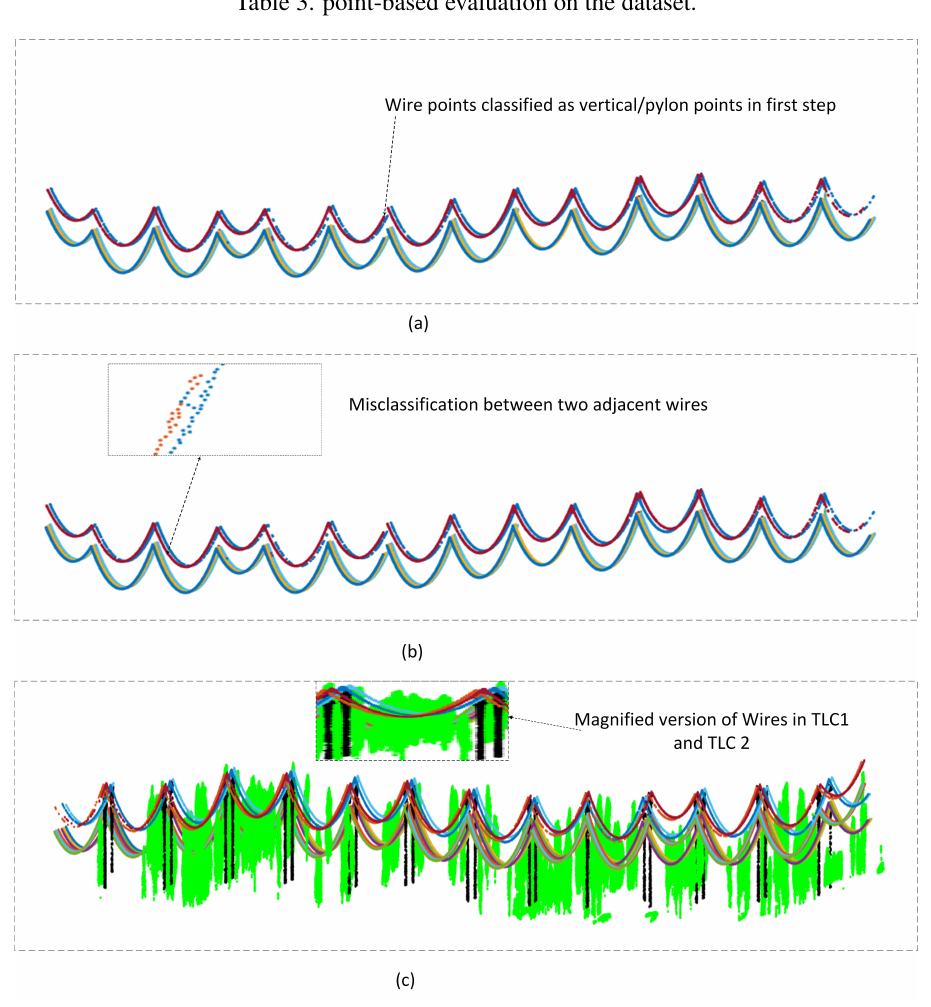
Figure 7. (a) Extracted wires in TLC 1, (b) Extracted wires in TLC 2, (c) Extracted wires, pylons and vegetation points. points may be wrongly misclassified. Though there is no wrong classification of PL points which are not in adjacent wires.